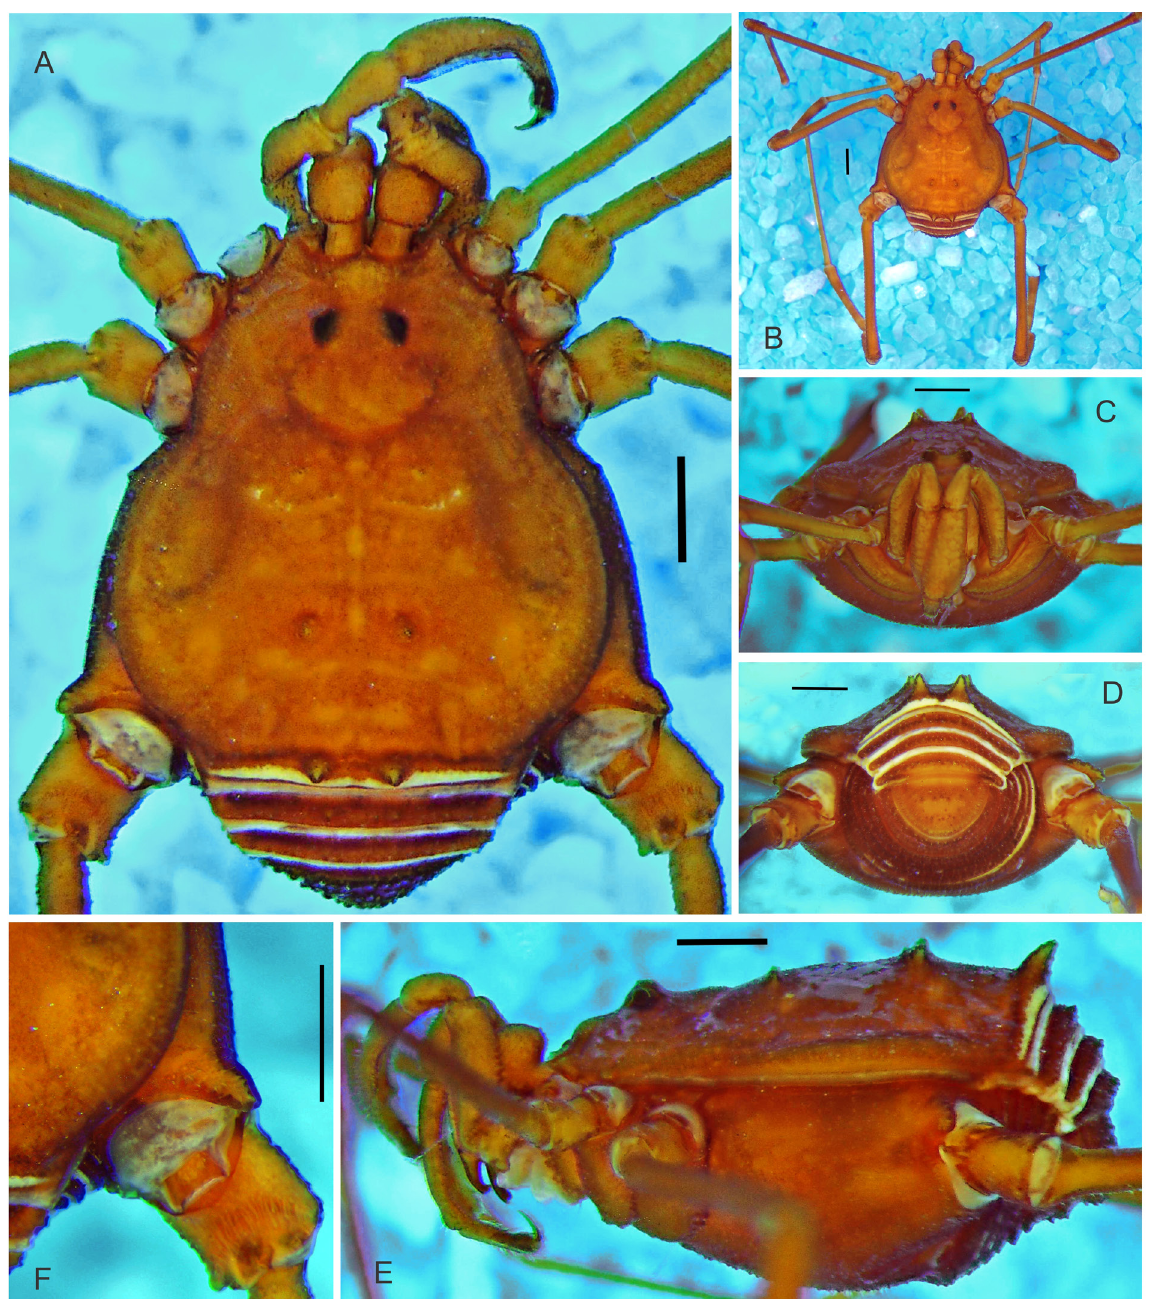
Fig. 5. Eulibitia castor sp. nov., ♂, holotype (ICN-AO 79), habitus. A . Dorsal view. B . Panoramic, dorsal view. C . Frontal view. D . Posterior view. E . Lateral view. F . Detail of apical apophysis of coxa IV. Scale bars: 1